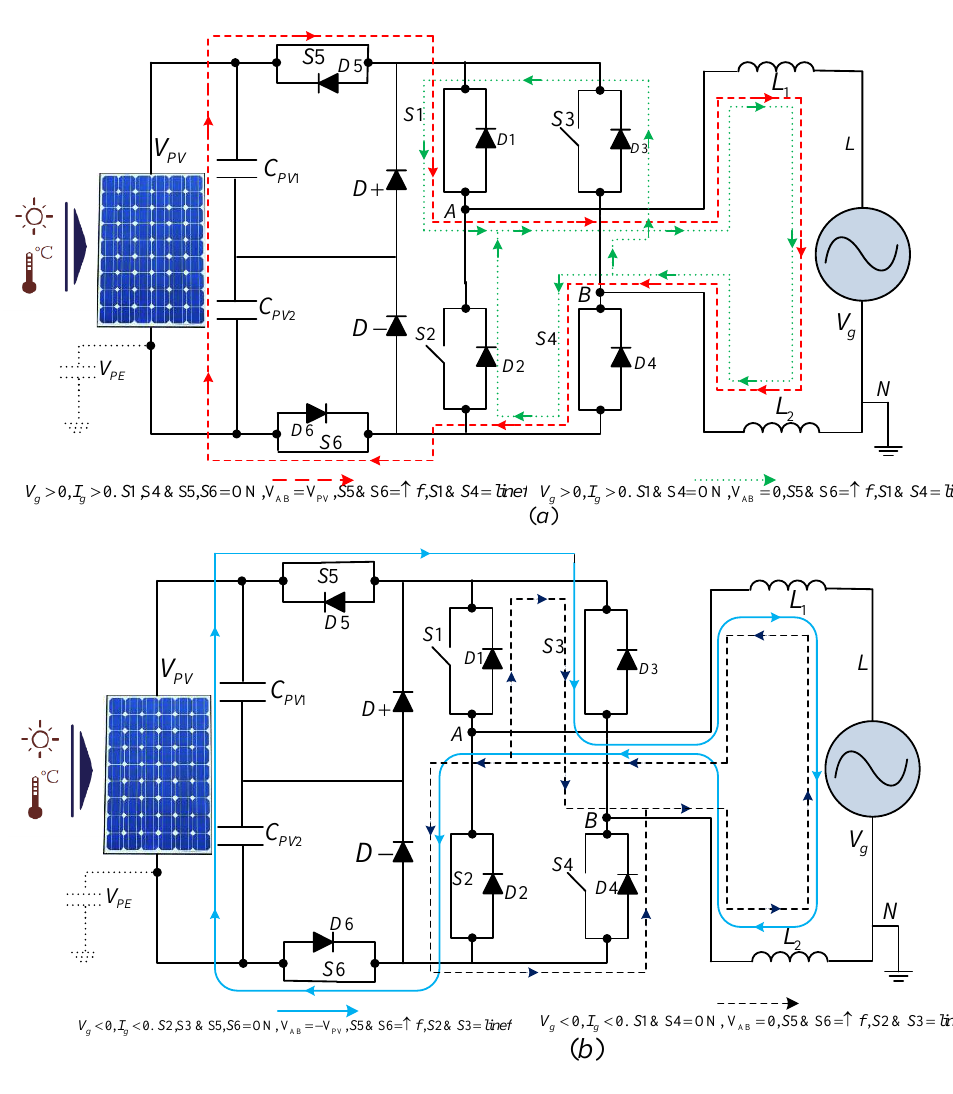
Figure 14. Switching positions of the Ingeteam FB-DCBP in case of: ( a ) positive cycle and ( b ) negative cycle [43,56].